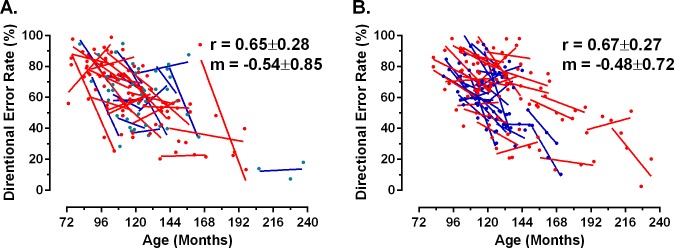
Effect of age on antisaccade directional error rate (DER).Presented calculated as a percentage for control (A) and cerebral malairia (B) groups. Plotting conventions as for Fig 1.